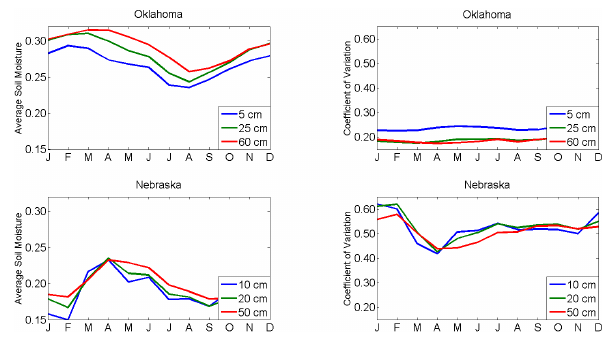
Fig. 2. Mean monthly soil moisture (cm 3 cm − 3 ) in Oklahoma (top Figure 2 . Mean monthly soil moisture (cm 3 /cm 3 ) in Oklahoma (top left) and Nebraska (bottom left) and mean monthly coefficient of variation in Oklahoma (top right) and Nebraska (bottom left) and Nebraska (bottom left) and mean monthly coefficient of right). Blue lines represent the near-surface soil (5 or 10 cm) while the green and red lines variation in Oklahoma (top right) and Nebraska (bottom right). Blue represent soil moisture at 20 or 25 cm and 50 or 60 cm, respectively. lines represent the near-surface soil (5 or 10cm) while the green and red lines represent soil moisture at 20 or 25cm and 50 or 60cm,